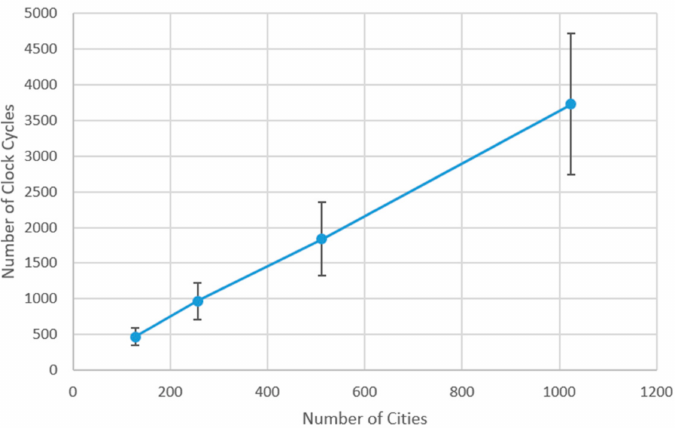
Figure 11. Speed variation for di ff erent chromosome